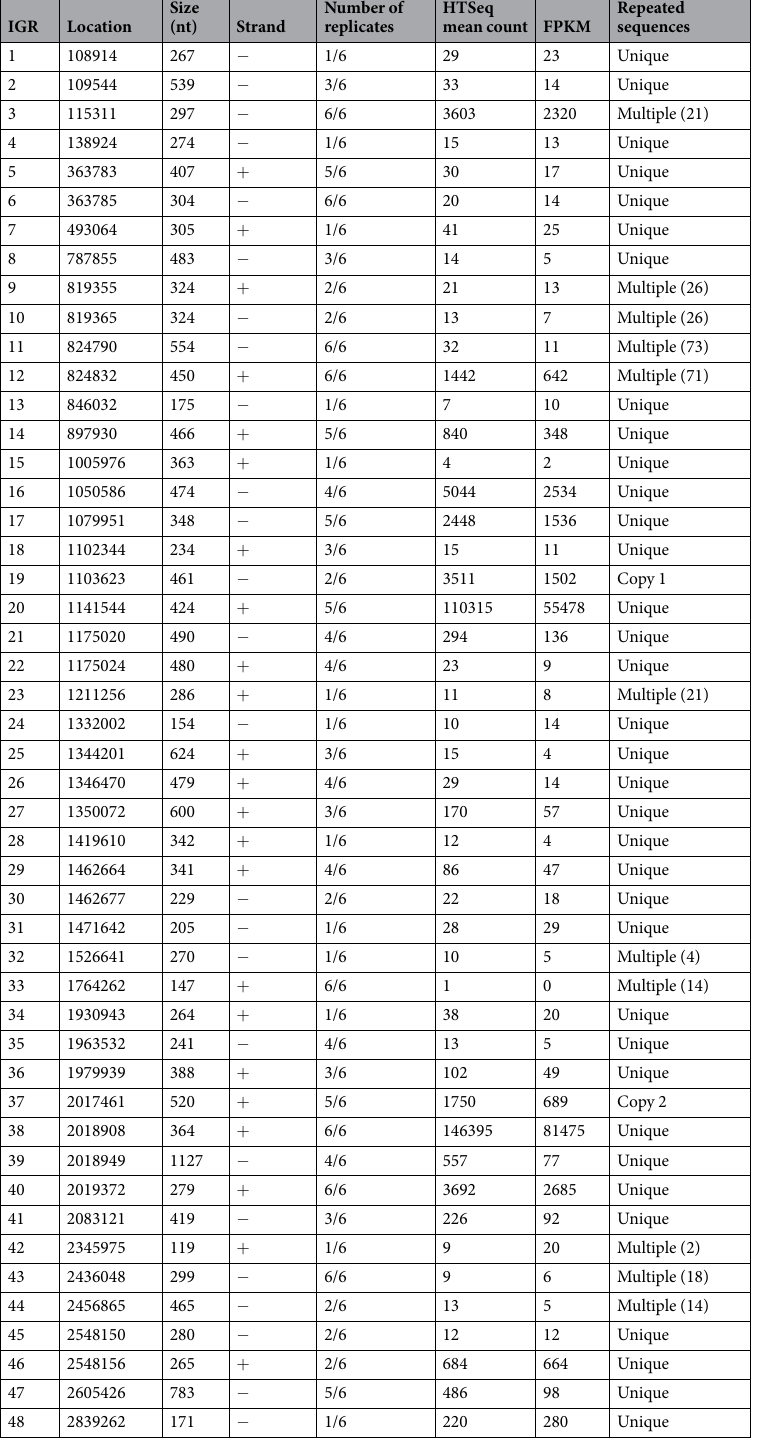
Table 1. RNA-Seq identification of 48 transcribed IGRs within the Staphylococcus aureus Newman strain. IGR, intergenic region; nt, nucleotides; FPKM, fragments per kilobase of exon per million reads mapped. When a sequence is repeated over the genome (at least 60% of the sequence of the candidate) the number of repetitions appears in